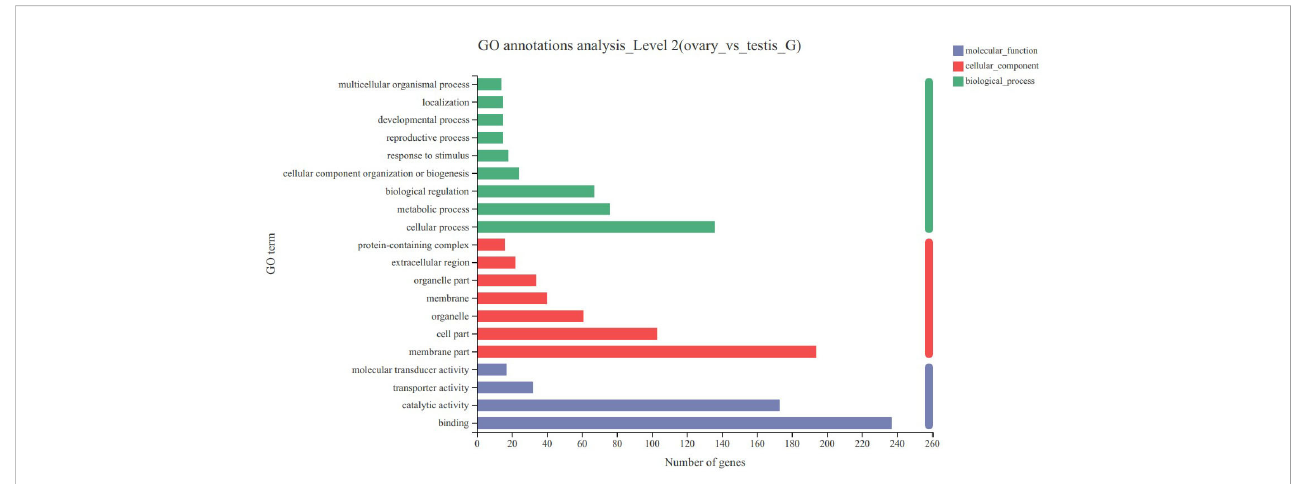
FIGURE 4 GO annotation analyses of differentially expressed genes (DEGs) in C. sinensis transcriptome. The left vertical coordinate indicates the second level of GO classi fi cation. The horizontal coordinate indicates the number of unigene/transcript included in this secondary classi fi cation, and the three colors on the right indicate the three major branches of